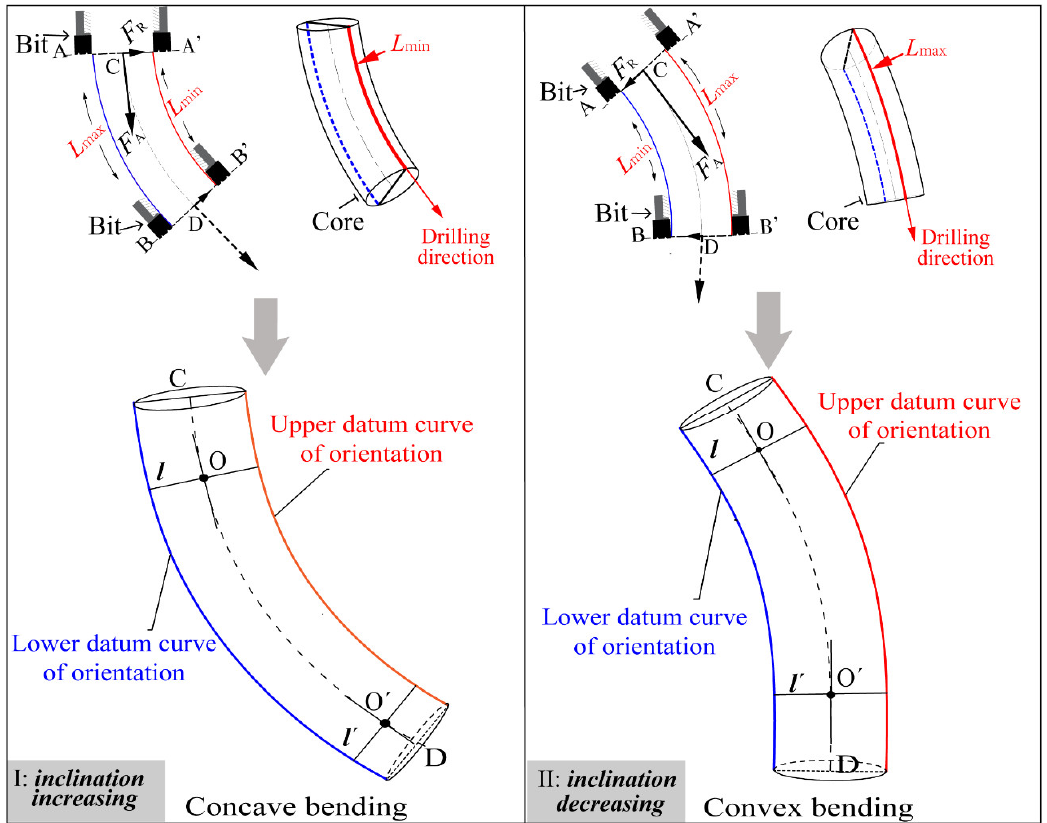
Figure 2. Spatial relationship between the datum curve of the orientation and the core bending feature ( F A : drilling force along the axial direction; F R : force along the radial direction; L min : shortest drilling arc; L max : longest drilling arc).